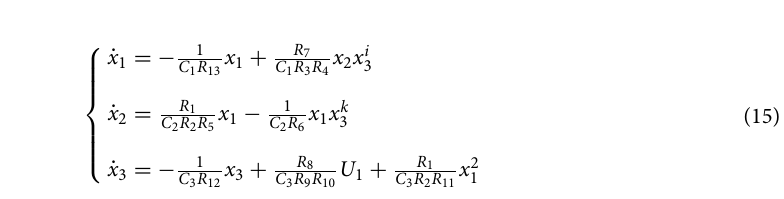
Figure 8. The quantitative relationships between i ( m ) and k ( n ) are i ( 2 ) bifurcation diagrams of system (8) with different values. ( a ) i ( 2 ) i ( 1 ) = 2 , the bifurcation diagram of system (8). ( c ) the bifurcation diagram of system